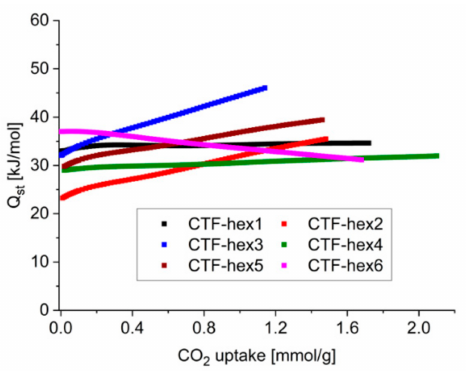
Figure 4. The variation of isosteric heat of adsorption ( Q st ) with the amount of CO 2 adsorbed for CTF-hex1 – 6 , calculated from a pair of adsorption isotherms measured at 273 K and 293 K using the Virial method